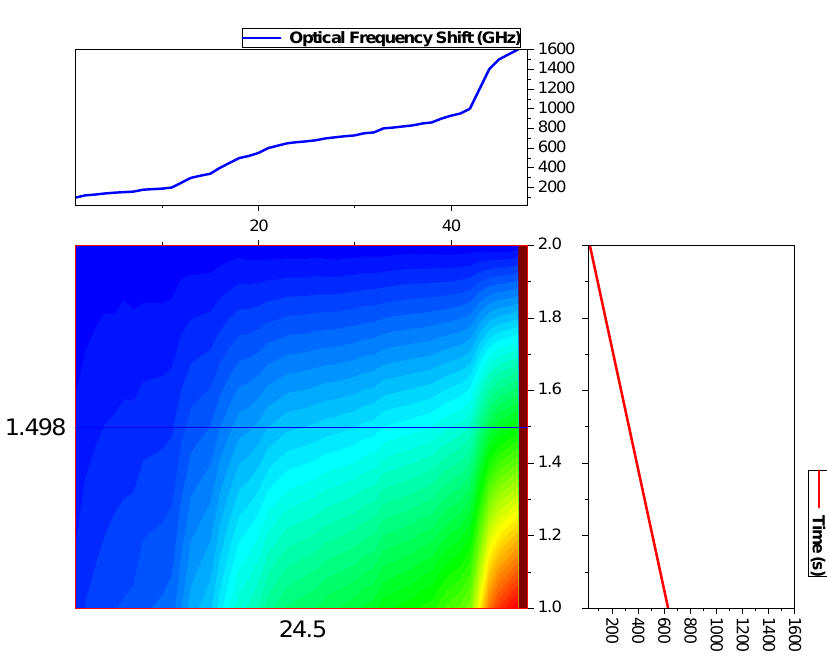
Figure 11. Experimental analysis of the implemented optical fiber for